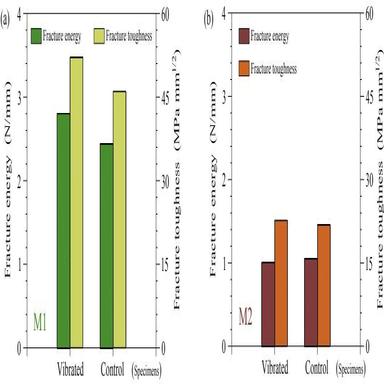
Fracture energy and Fracture toughness for M1 (a) and M2 (b) mortars.